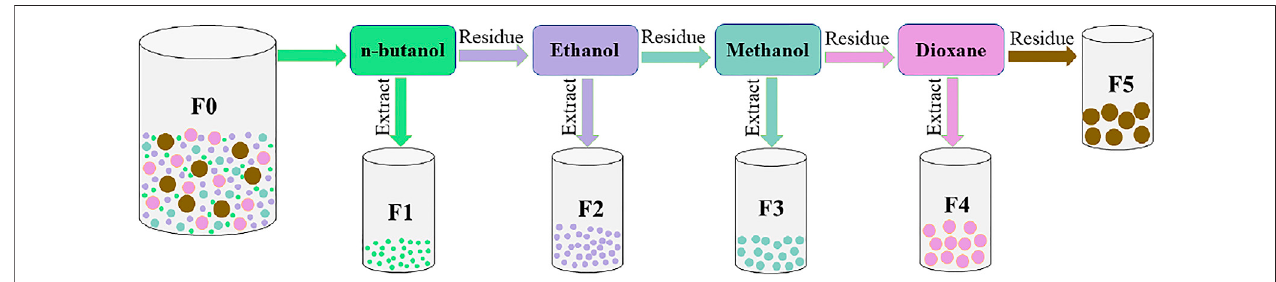
FIGURE 1 | Scheme for sequential organic solvent fractionation of tobacco stalk lignin.